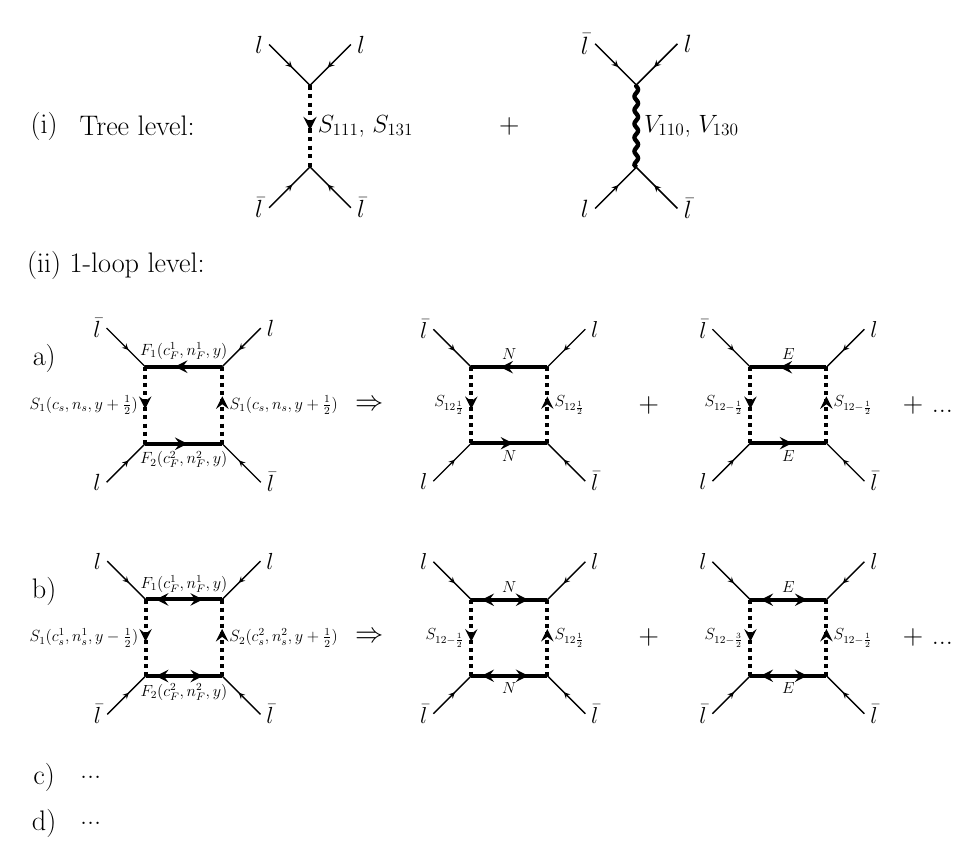
Figure 2. The figure illustrates the construction of UV models for a given diagram with fixed outside legs. For simplicity of presentation we have chosen a symmetric operator, O ple, since it yields the minimal number of models (four at tree-level). Note that in diagrams with specific particles inserted, we use arrows to track the flow of quantum numbers, such as colour and hypercharge. For vector-like and Majorana fermions, the double arrows indicate a mass